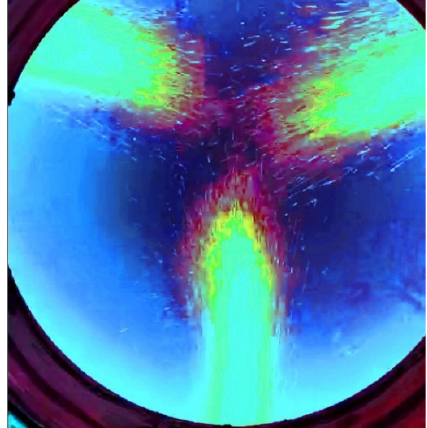
Fig. 2. Three independent powder spray torches – view through the peephole window in the upper bottom of the spray chamber.